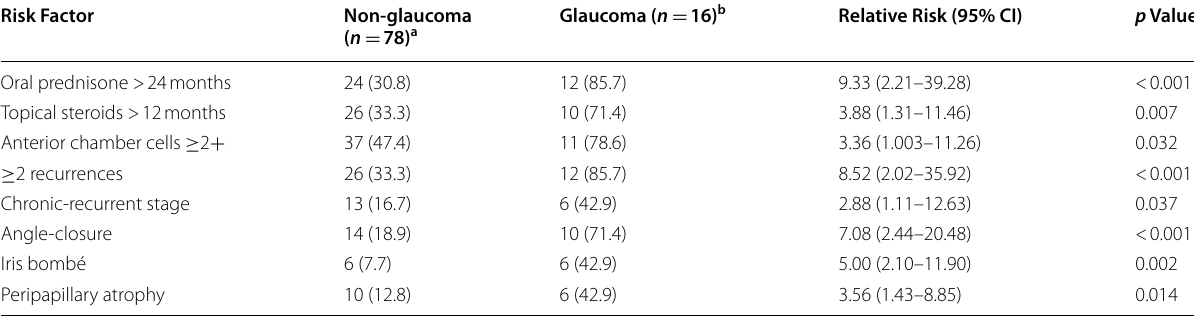
VKH Vogt‑Koyanagi‑Harada a Two eyes without management with oral prednisone (convalescent stage) were